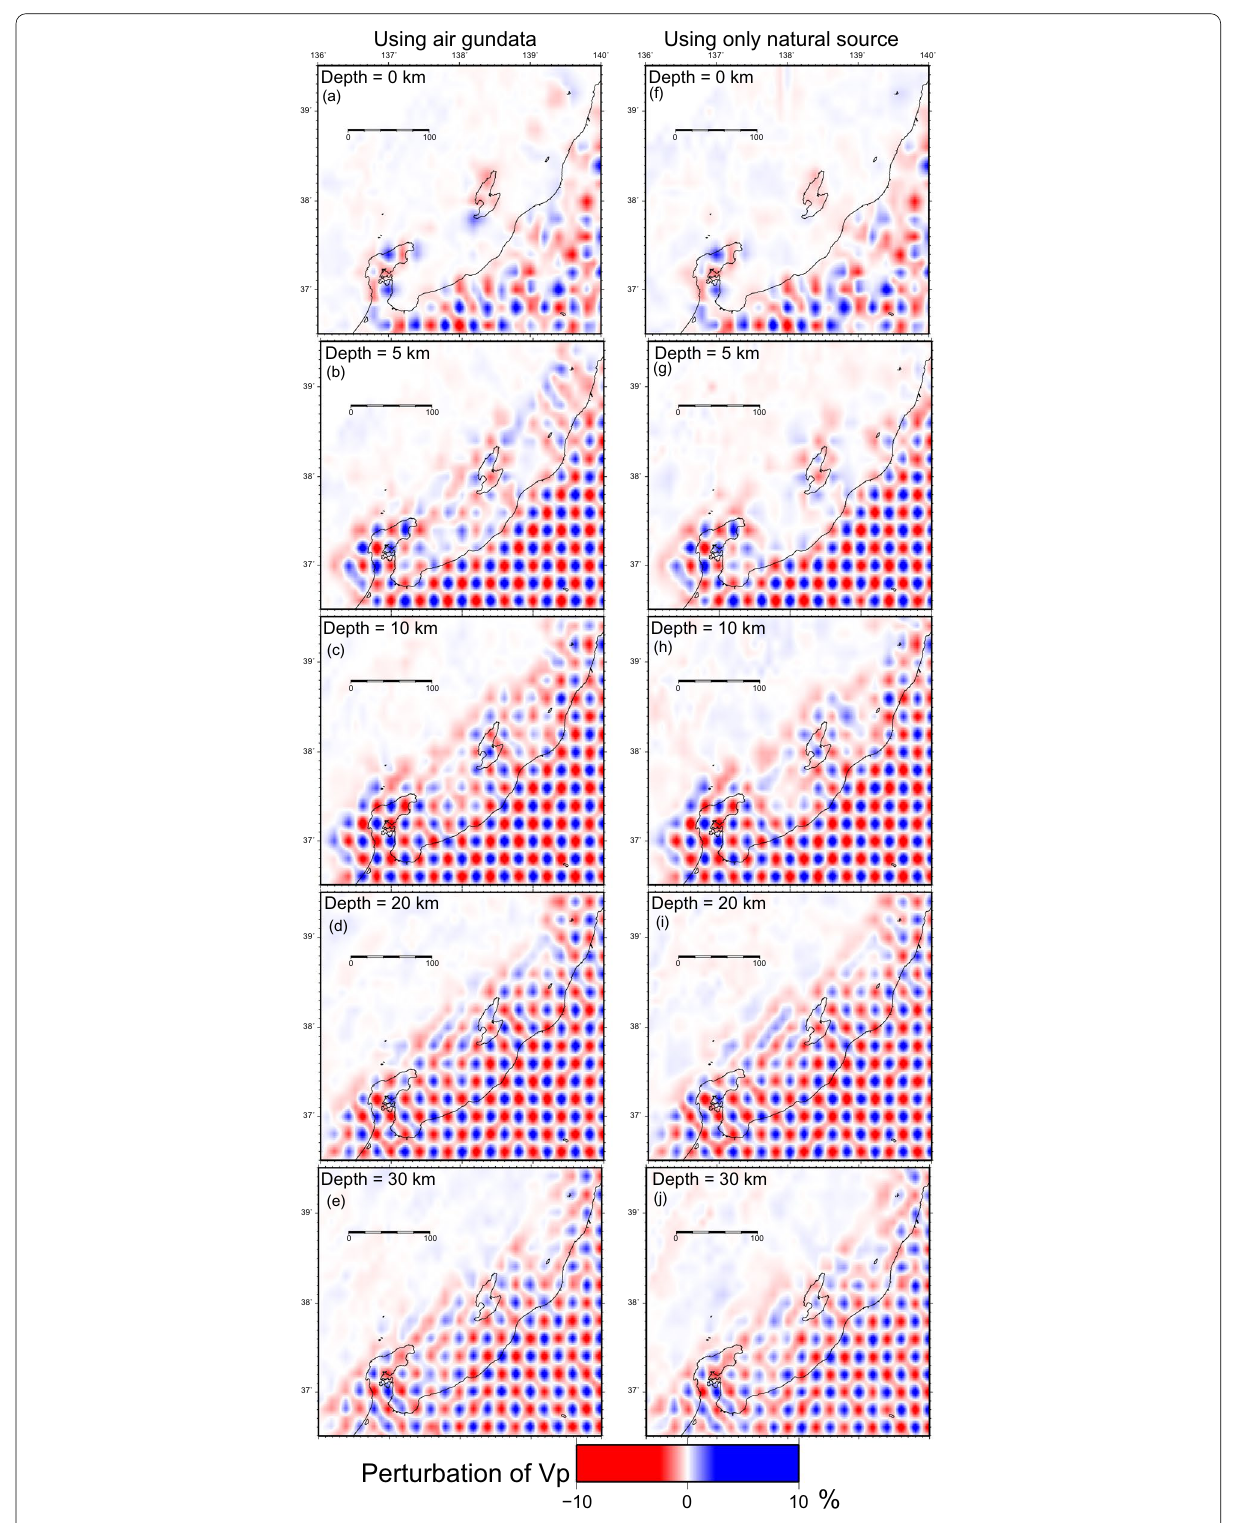
Fig. 9 Result of checkerboard resolution test with/without reflection seismology at the central coast of Sea of